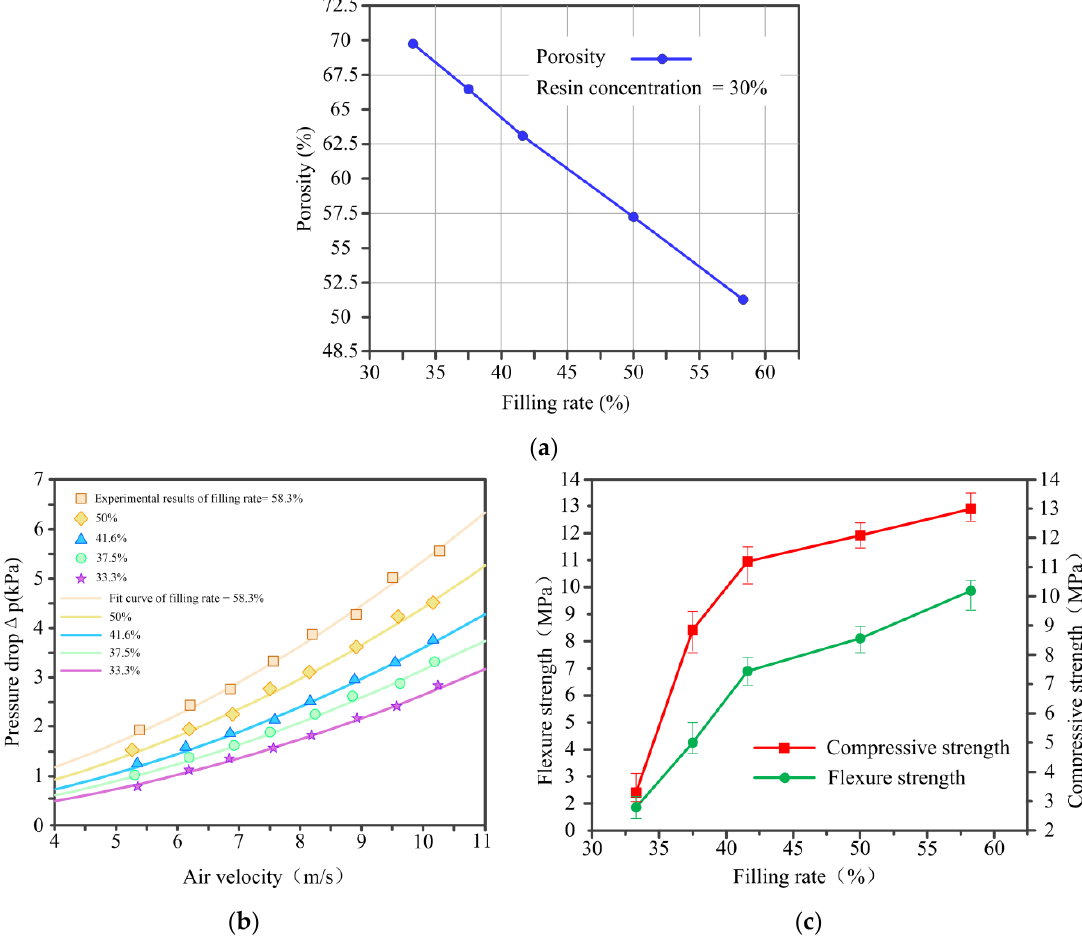
Figure 11. Experimental results of ( a ) porosity, ( b ) air permeability and ( c ) mechanical properties of C WCMs, with filling rate of wood powder of 33.3%, 37.5%, 41.6%, 50% and 58.3%, under a constant resin concentration of 30%. Table 2. Permeability constants and crystallite size of C WCMs sample with different filling rate under a constant resin concentration of 30%.